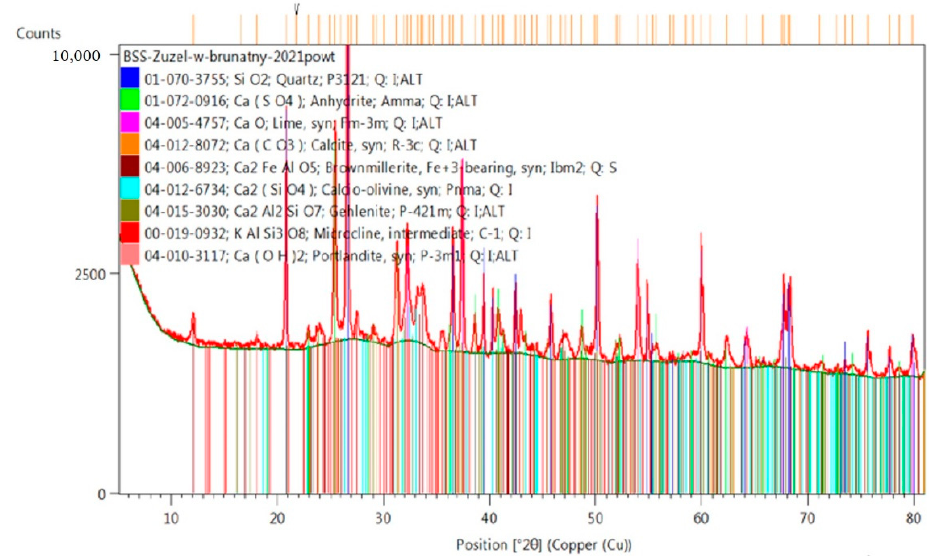
Figure 5. Phase composition of LFS.